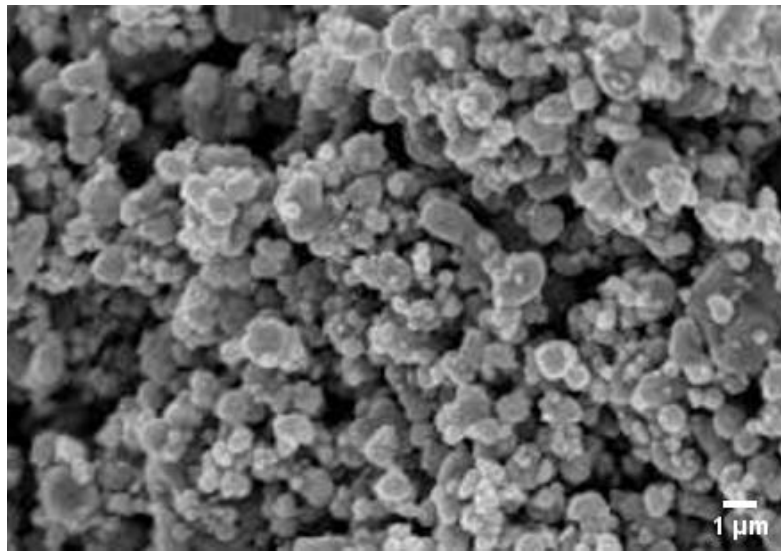
Figure 4. SEM image of silver nanoparticles.